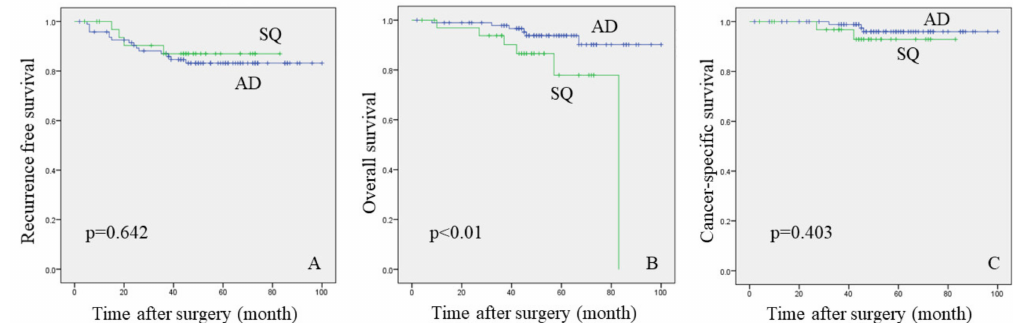
Figure 2. Kaplan-Meier curves (( A ) recurrence free survival, ( B ) overall survival, and ( C ) cancer- specific survival). Differences in survivor function between patient groups were assessed using the log-rank test. AD, adenocarcinoma; SQ, squamous cell carcinoma.